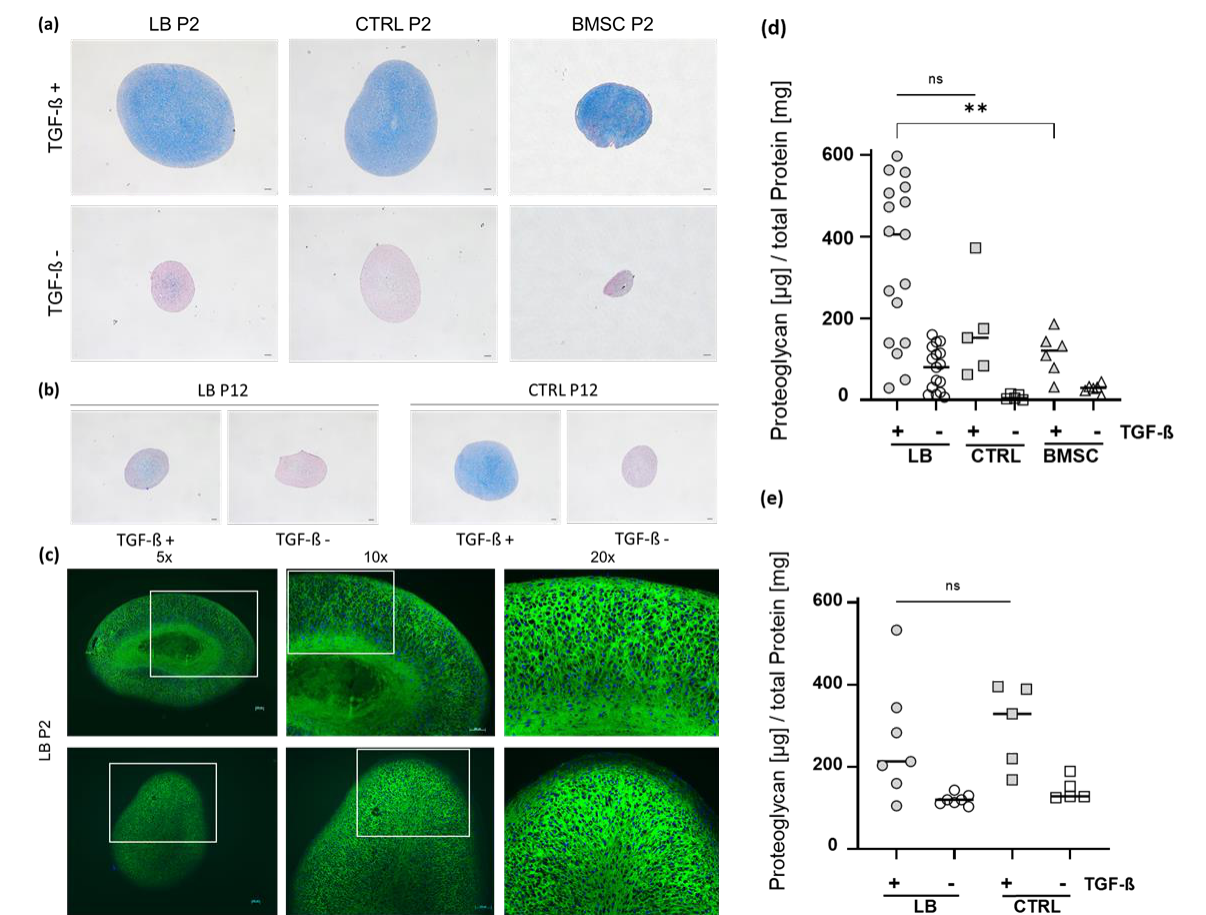
Figure 4. Chondrogenic differentiation of early and late passage chondrocytes and BMSCs. ( a ) Alcian blue staining of early passage (P2) LB-CH, CRTL-CH and BMSCs after 21 days of differentiation. Counter staining was performed with nuclear fast red (nucleic acid stain). All pictures are taken with a 5 × magnification (total 50 × ), Scale bar: 100 µ m. ( b ) Alcian blue staining of late passage (P12) LB-CH and CRTL-CH after 21 days of differentiation. Counter staining was performed with nuclear fast red (nucleic acid stain). ( c ) Immunohistochemistry of collagen type II (green) of early passage LB-CH. Nuclei were stained with DAPI (blue). ( d ) Proteoglycan content normalized to the total protein of early passage (P2) LB-CH ( n = 17), CTRL-CH ( n = 5), and BMSC ( n = 6) cultures. ( e ) Smaller sample size was used to assess chondrogenic differentiation capacity of late passage (P12) LB-CH and CTRL-CH cultures; LB n = 7, CTRL n = 5. Repeated measures, median line depicted, one-way ANOVA with multiple comparisons (Tukey), p -values of multiple comparisons as depicted, ns = not significant, ** = p ≤ 0.01.